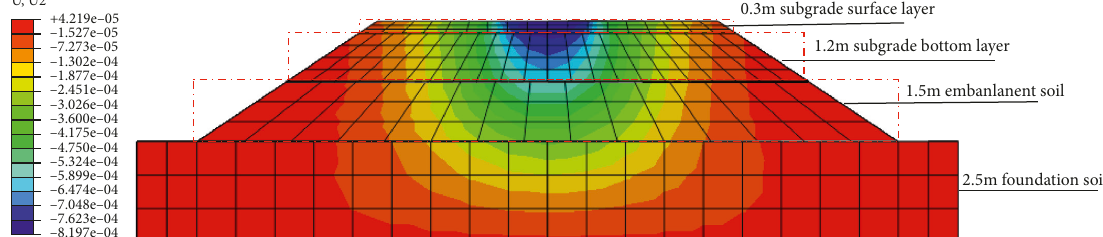
Figure 15: Deformation distribution cloud map of the cross section of the foundation